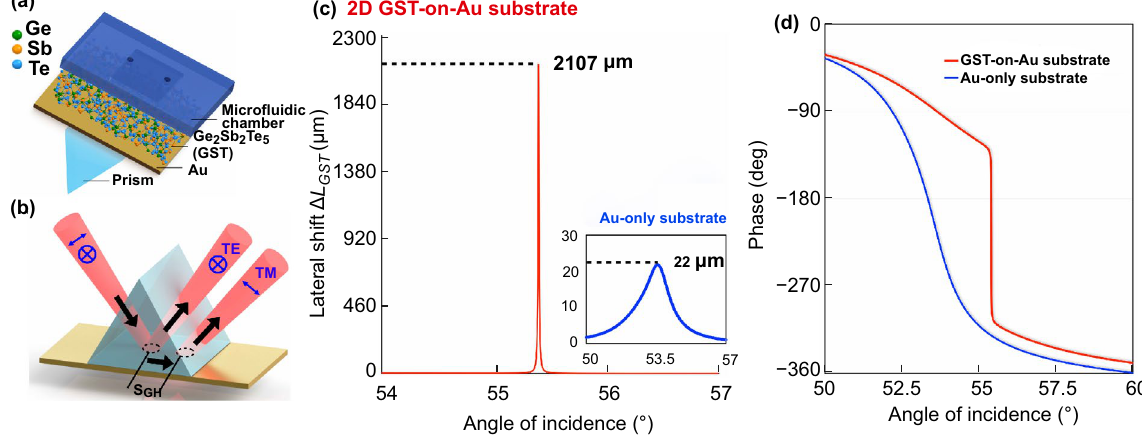
Fig. 1 a Schematic of the sensing substrate based on GST‑gold metastructures. b Schematic diagram of the giant lateral position shift induced by the GST‑on‑Au substrate. Simulation results of c lateral position shift and d optical phase signal change based on 2D GST‑on‑Au substrate and Au‑only